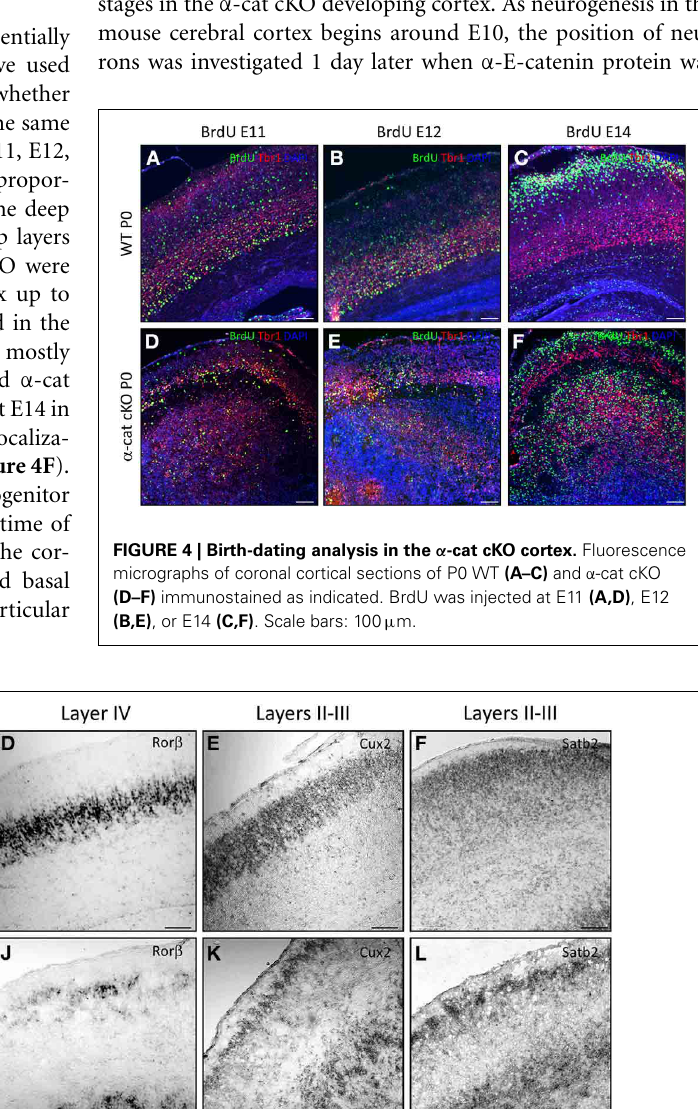
hybridization (ER81, ror β , cux2, satb2) as depicted in the panels. (A,B,G,H) : pial surface is indicated by dashed lines. Scale bars: 10 μ m (A,B,G,F) ; 100 μ m (C–F,I–L)